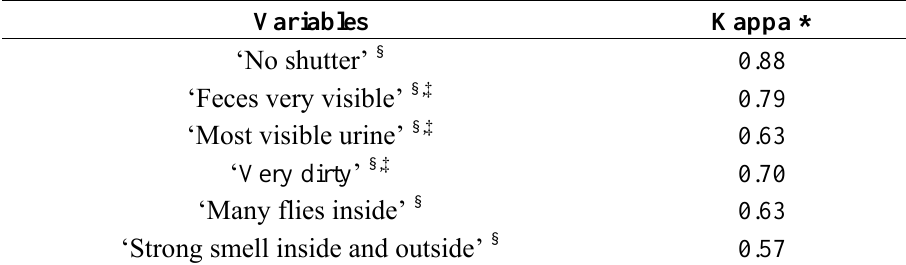
Table A1. Inter-rater reliability for the subjective toilet